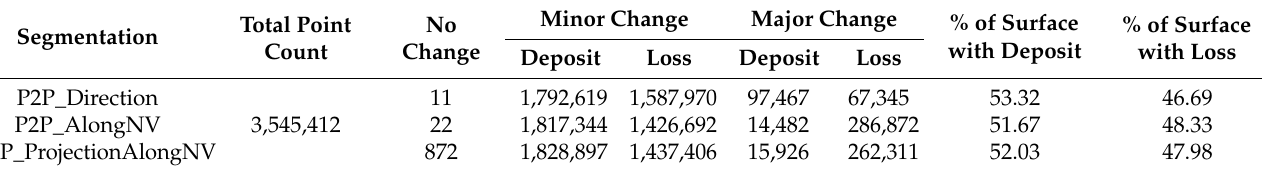
Table 16. Analysis of surface points count on the surface of NGL2.